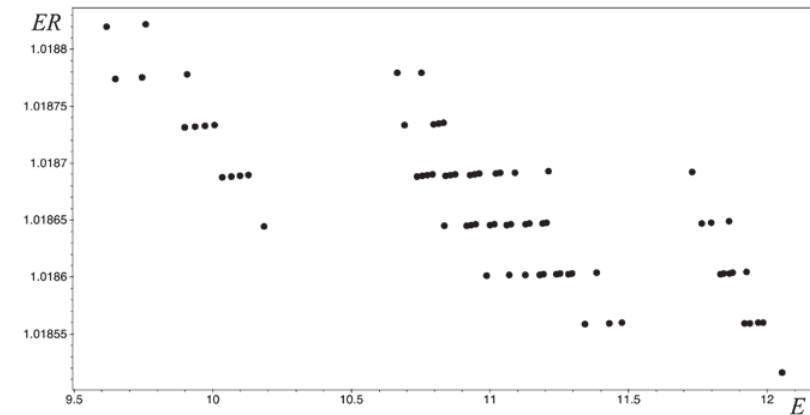
Figure 1. The relation between the resolvent energy of graph (ER) and the graph energy (E) in the case of 75